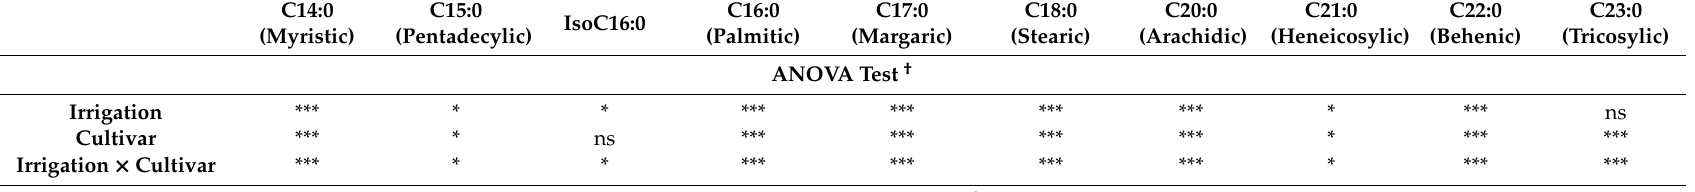
Table 6. Saturated fatty acid (SFA) profile in raw almonds a ff ected by cultivar and irrigation